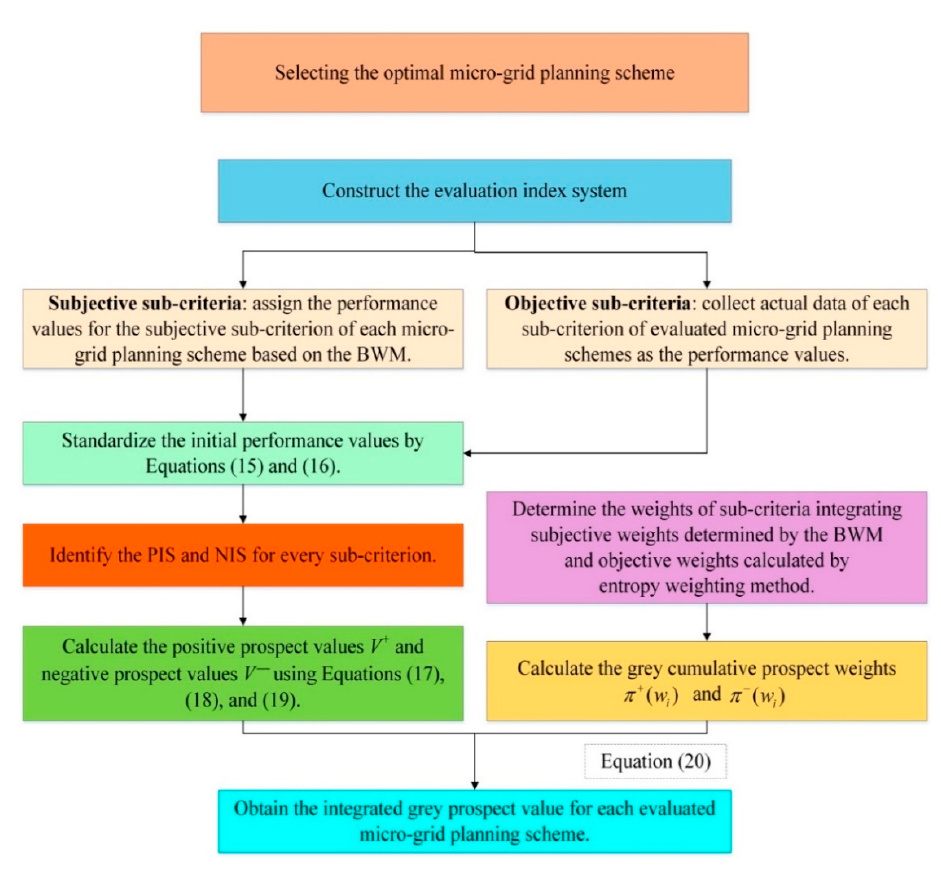
Figure 1. The procedure of the established multi-criteria decision making (MCDM) model for selecting the optimal micro-grid planning program.